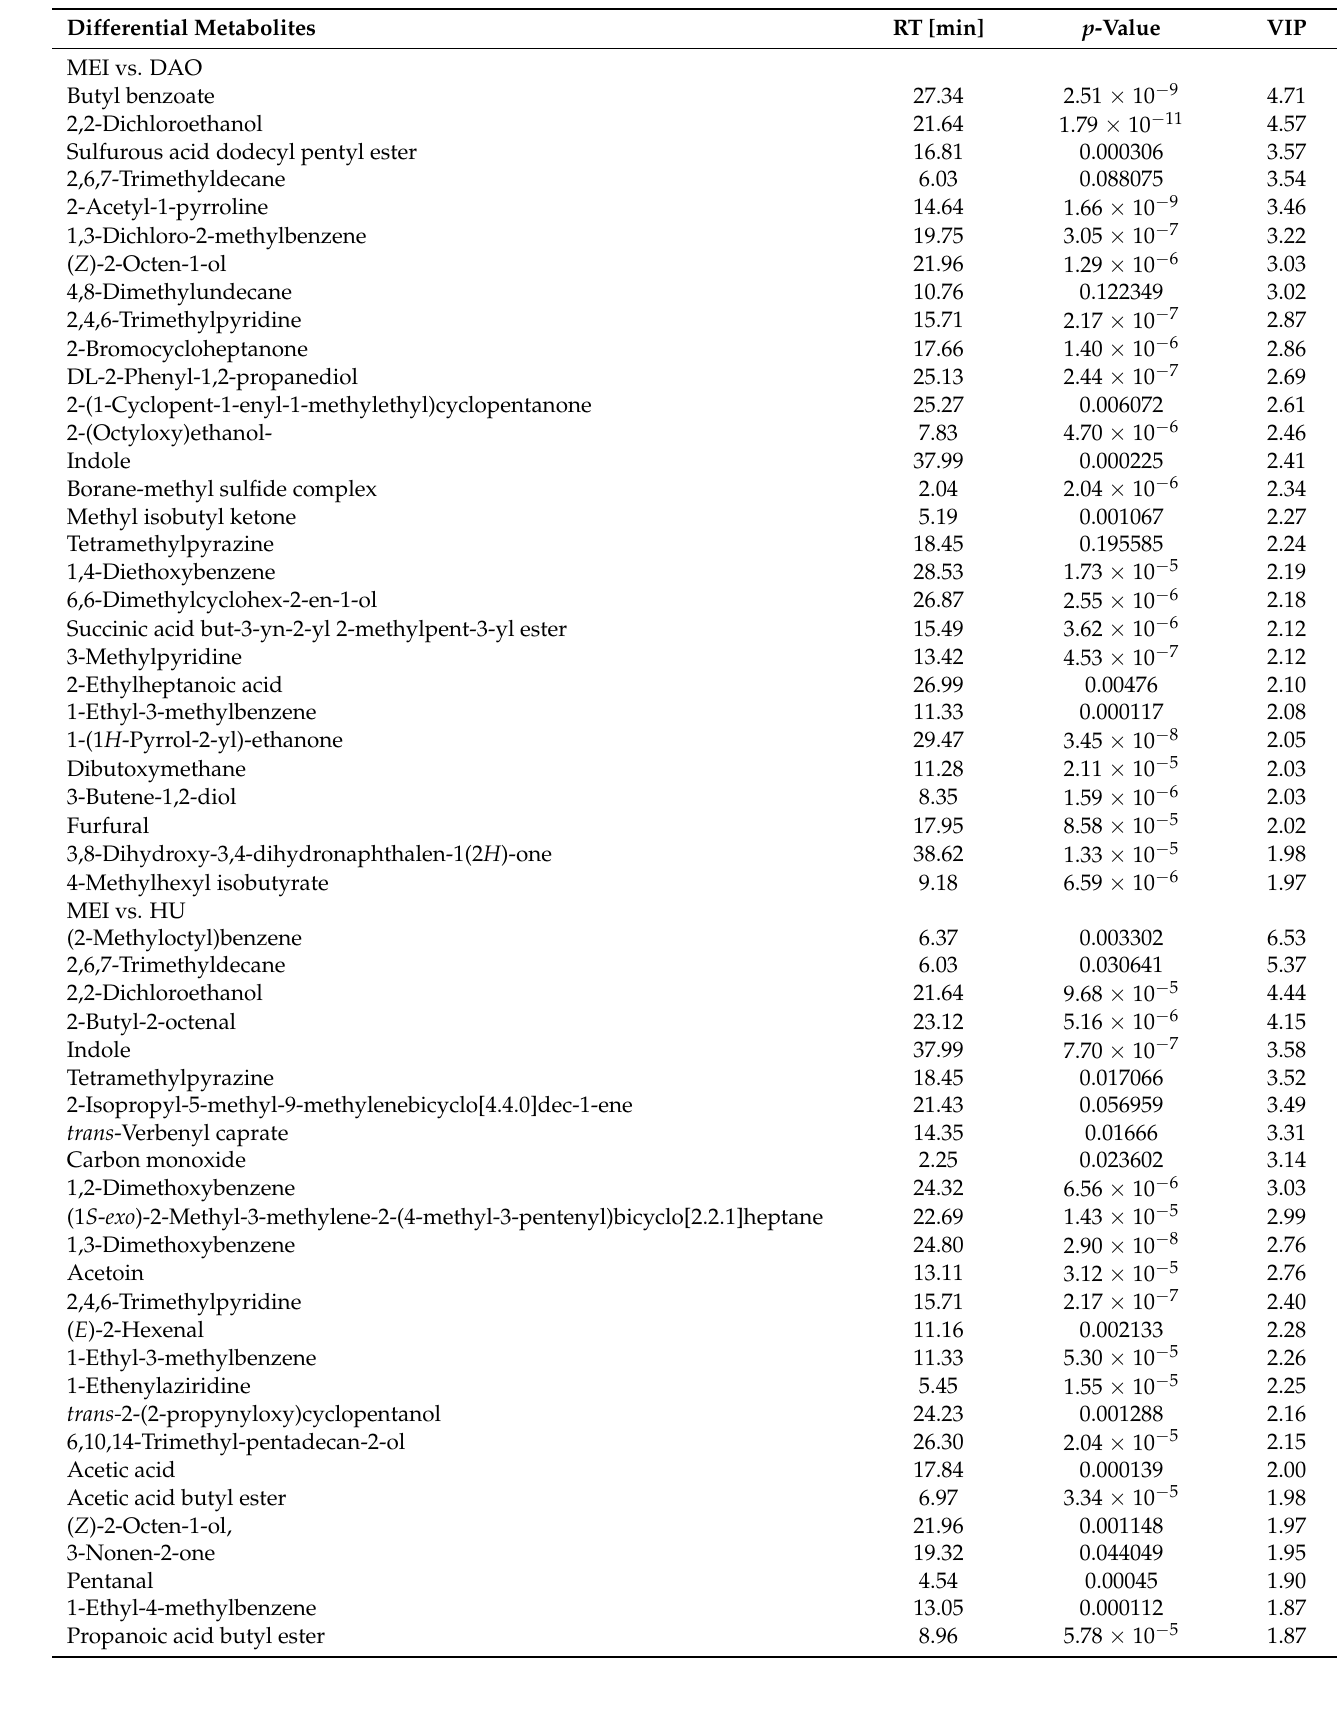
Table 2. Selected differential metabolites across all pairwise